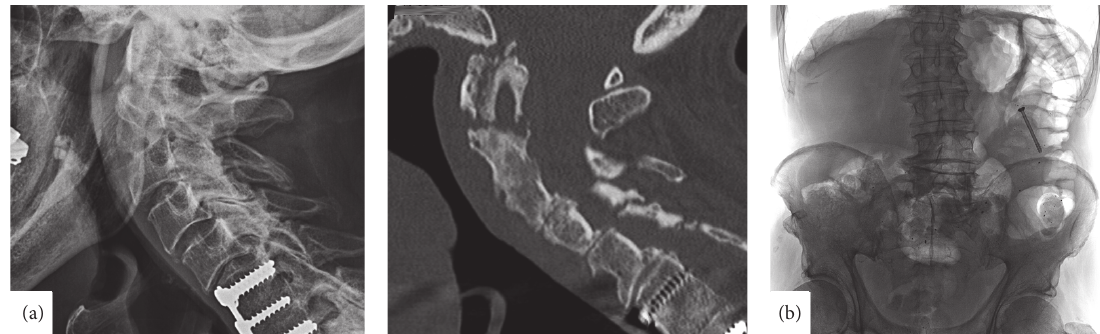
Figure 3: (a) X-ray (left) and computed tomography (CT) (right) show missing odontoid screw and not consolidated fracture gap, sagittal view. (b) Abdomen X-rays displaying an odontoid screw in the left upper abdomen, presumably descendent colon, with no signs of free peritoneal air, a.p.